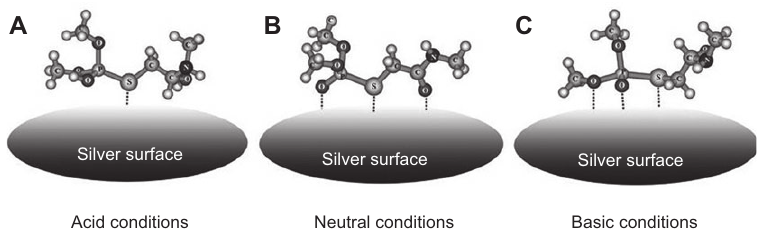
Figure 8 Probable adsorption orientation of omethoate onto the Ag surface at different pH conditions: (A) acidic, (B) neutral, and (C) alkaline. Reproduced with permission from: Kim et al. (2011) . Copyright 2011,